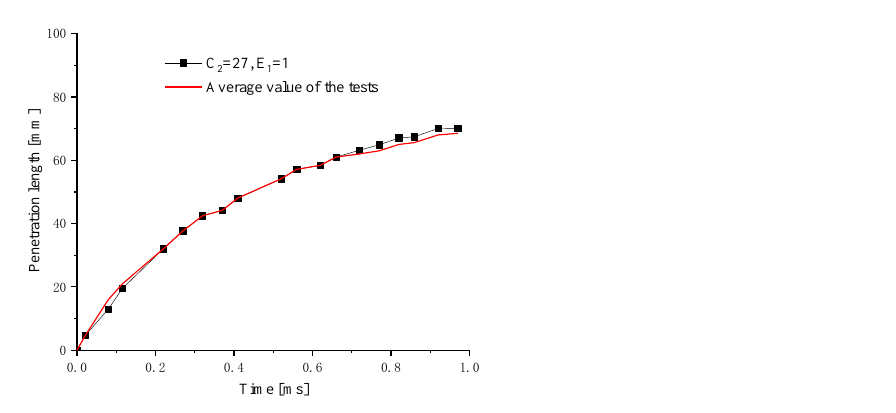
Figure 11. Comparison of the vapor penetration length between the simulated and experimental results.